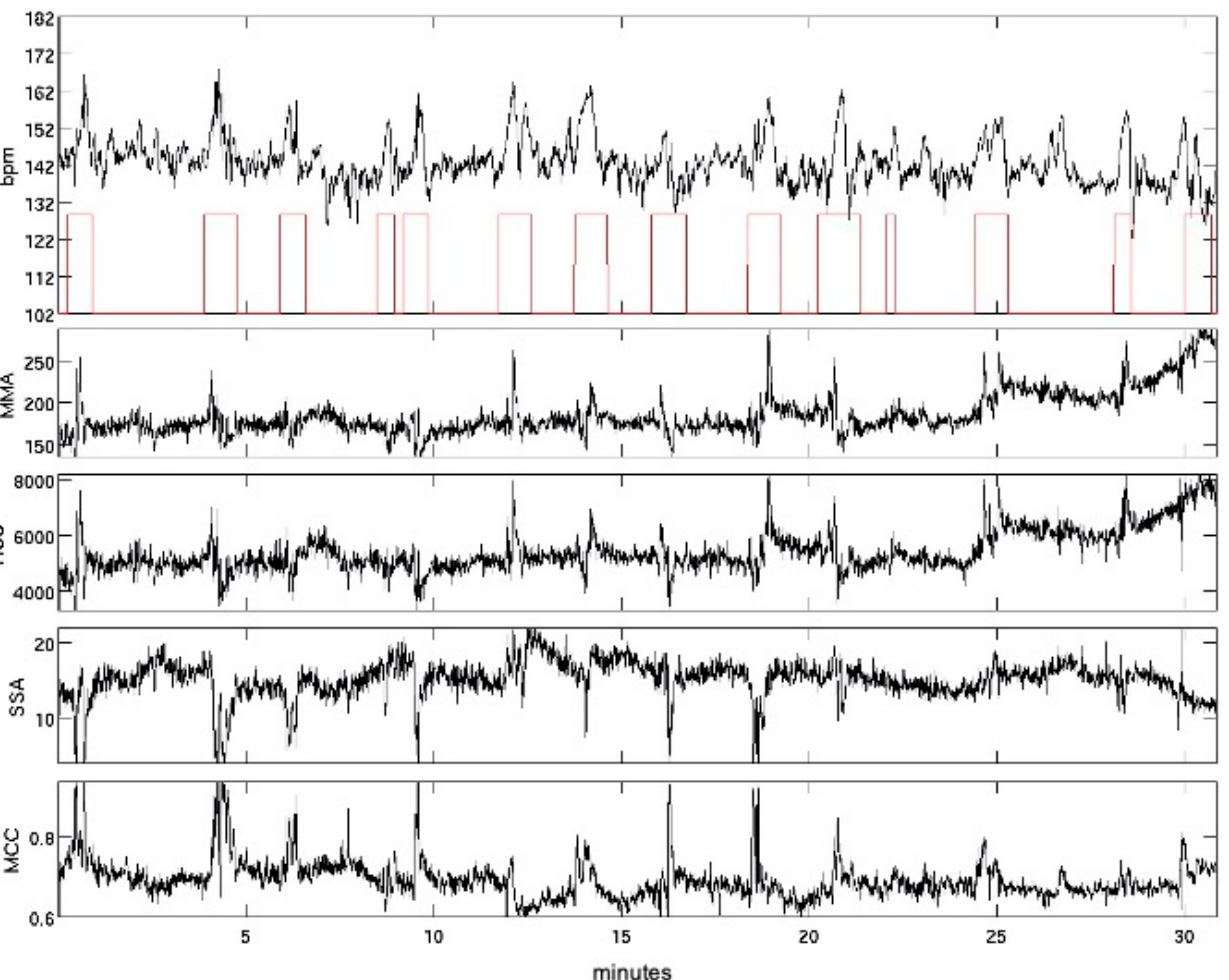
Figure 1. Calculation of fetal movements from MCG recording. Heart rate trace (black line) and sections of identified body movements (red boxes). Four calculation approaches were combined to detect spatial shift of the cardiac vector within the sensor array in all dimensions: Minimum Maximum Amplitude (MMA), L2-Norm of the heart vectors (RSS), Signal Space Angle (SSA) and Moving Correlation Coefficient (MCC) (details in [17,22]).